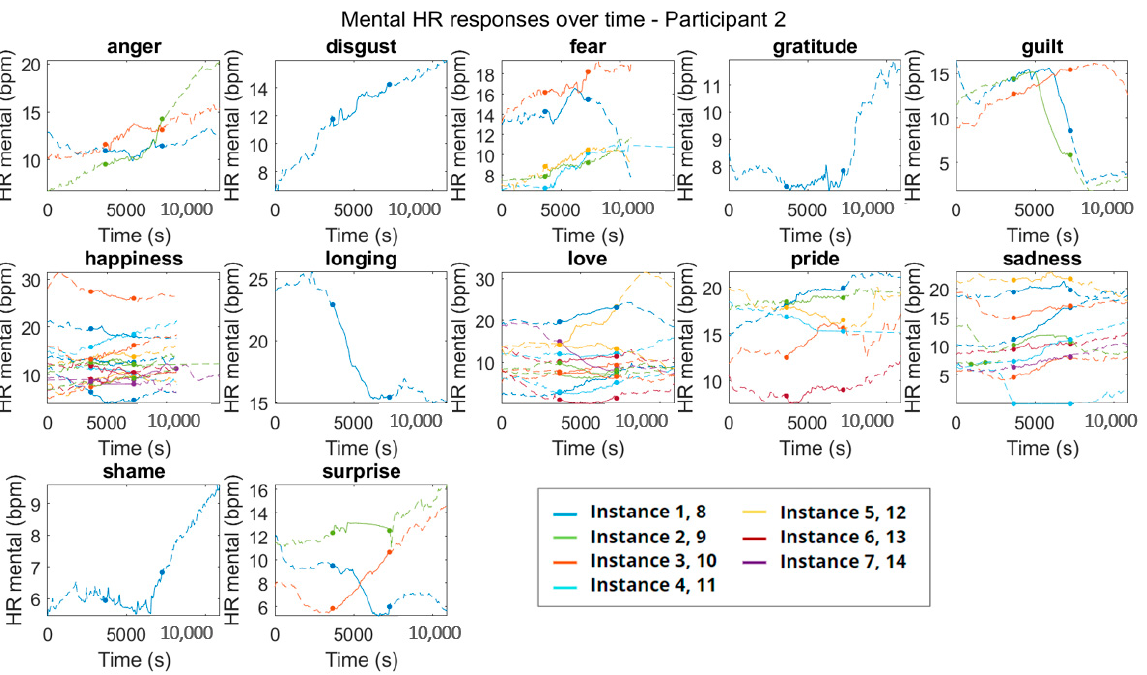
Figure 6. Response of the pre-processed mental HR component in function of time for each emotion (solid line) of participant P2. Each colour represents a different event of that specific emotion. The dotted lines are the mental HR response right before and after the